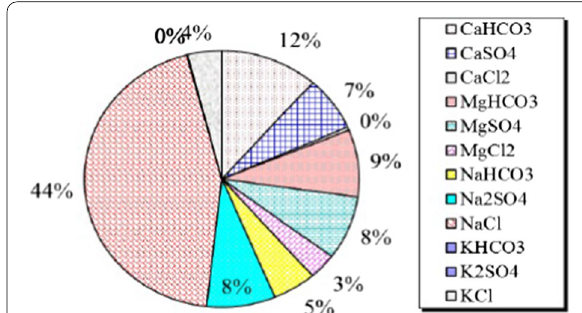
Fig. 8 Hypothetical salt combinations of the obtained samples in the area